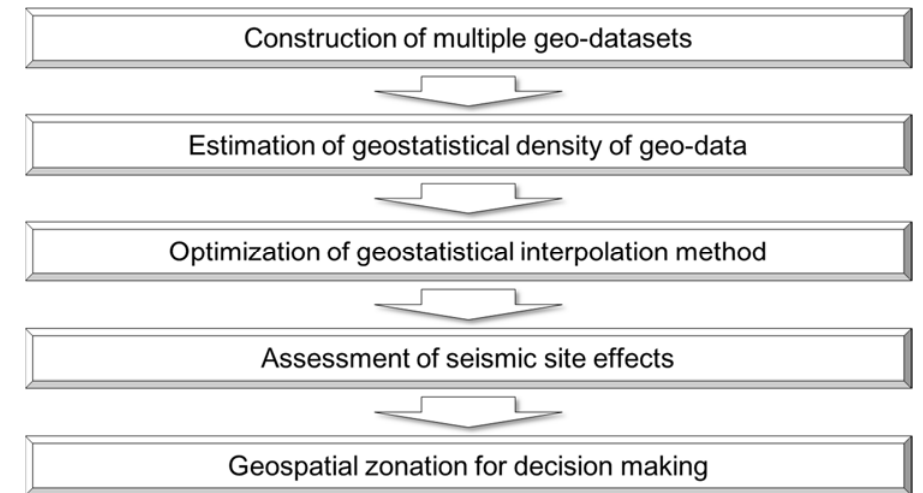
Figure 1. Framework architecture of the GIS-based geospatial zonation.